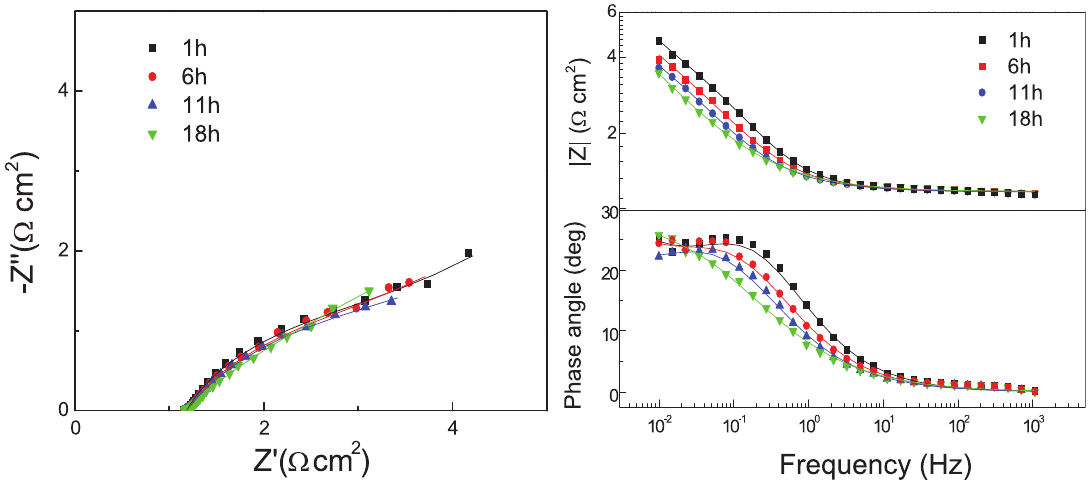
Fig. 5: Nyquist (a) and Bode (b) diagrams of pure chromium in molten (Li,Na,K)F at 973 K (Symbol: experimental data; Line: fitted data)